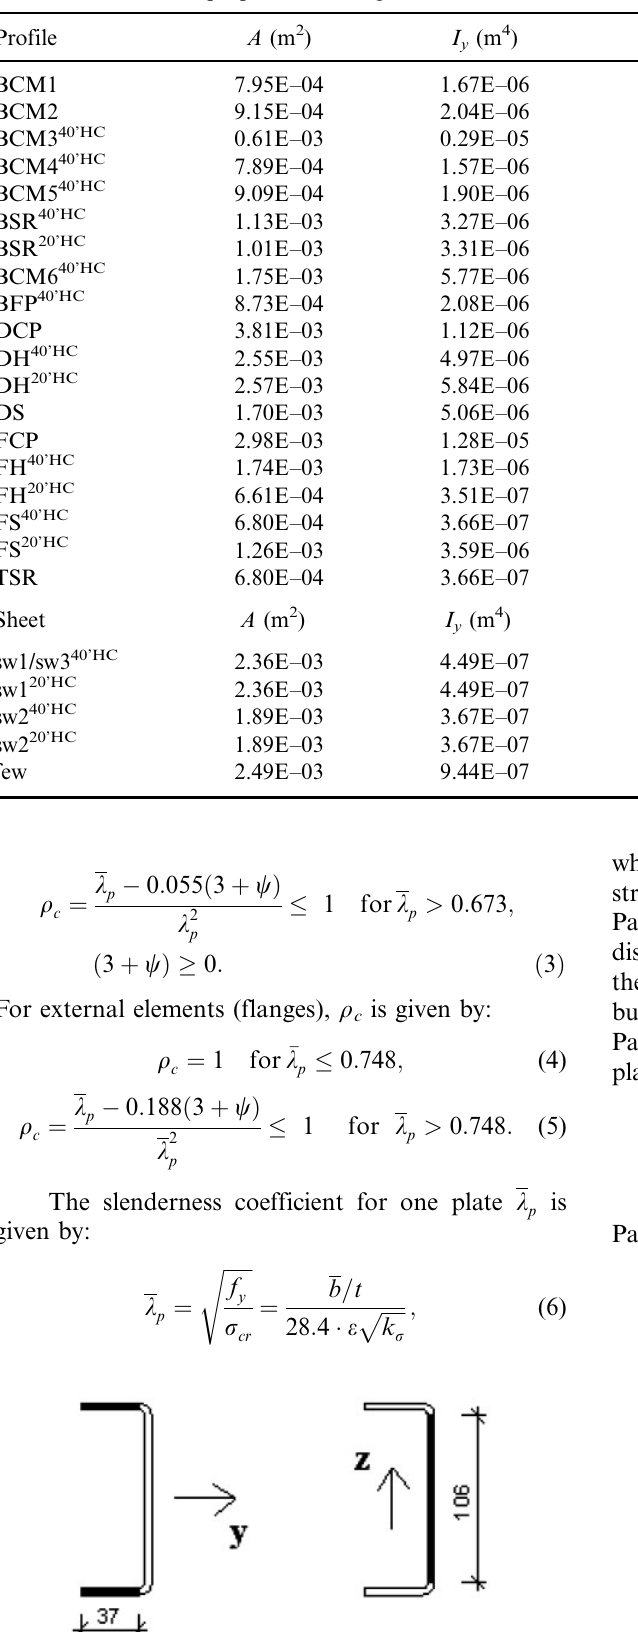
Table 4. Geometrical properties of the gross sections